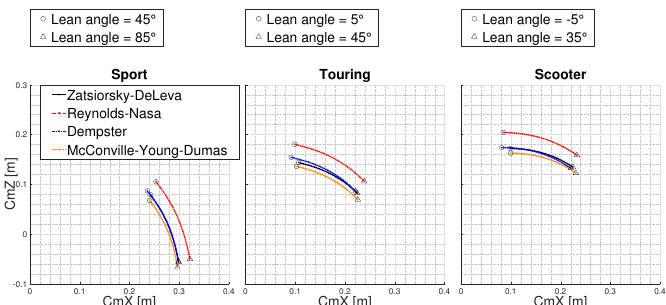
Figure 8. Position of the center of mass as a function of lean angle.